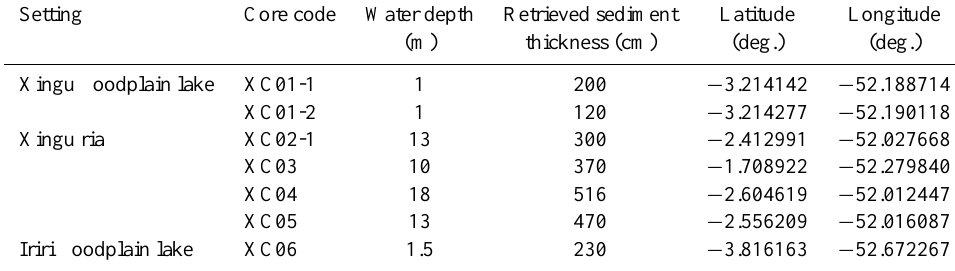
Table 1. Sediment cores retrieved in the Xingu ria and floodplain lakes of the Xingu and Iriri rivers. Setting Core code Water depth Retrieved sediment Latitude Longitude (m) thickness (cm) (deg.)